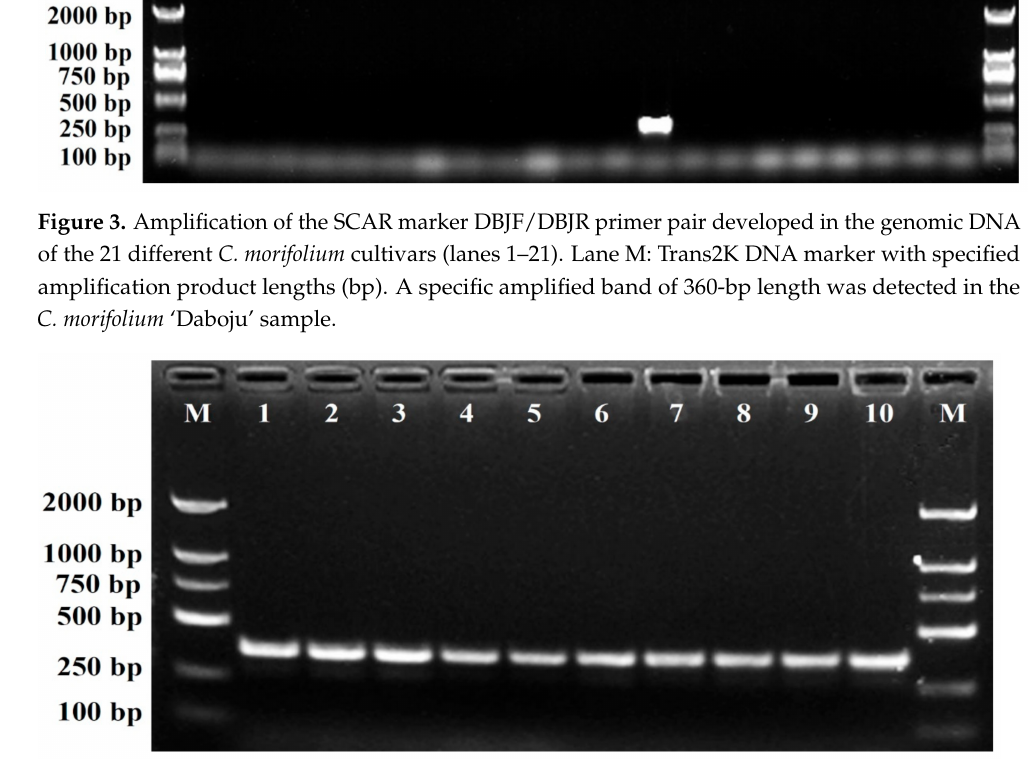
Figure 4. Amplification profiles of the primer pair DBJF/DBJR in the ten C. morifolium ‘Daboju’ samples (lanes 1–10). Lane M: Trans2K DNA marker with specified amplification product lengths (bp). The specific amplified bands of 360-bp length were detected in all the C. morifolium ‘Daboju’